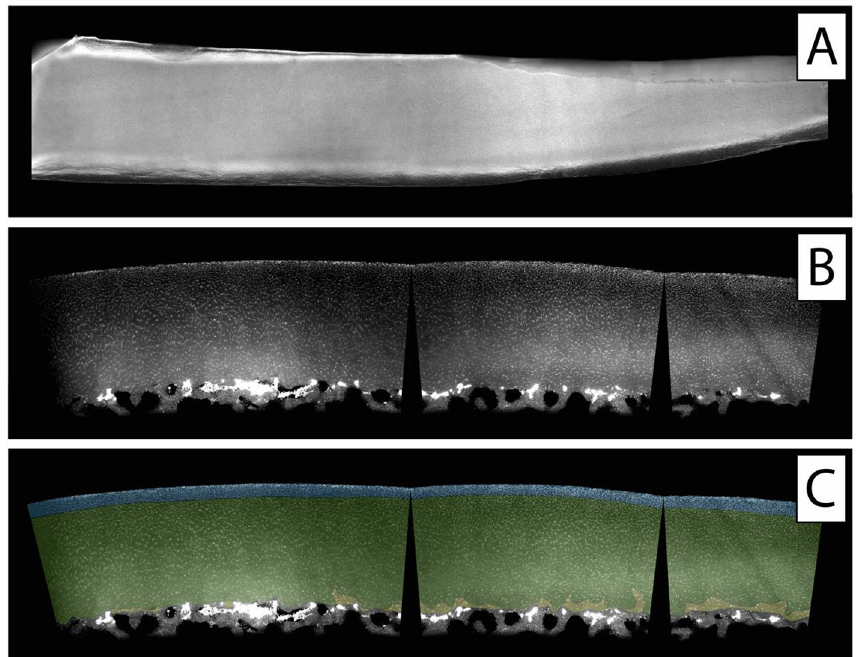
Figure 2. Top-down ( A ) and side view ( B , C ) of a healthy cartilage sample. ( C ) Zonal colour labelling of the predominant spatial chondrocyte arrangement: blue—superficial zone, green—single strings, yellow—double strings, grey—subchondral bone. The sample still shows an intact superficial zone. Underlying is a thick layer of healthy cartilage composed of single strings. Only at the transition to the subchondral bone some isolated double strings can be detected. The black wedges are a digital artefact of straightening the image. This figure was created using Adobe Photoshop CS6 (https:// www. adobe. com/ ch_ de/ produ cts/ photo shop. html) and